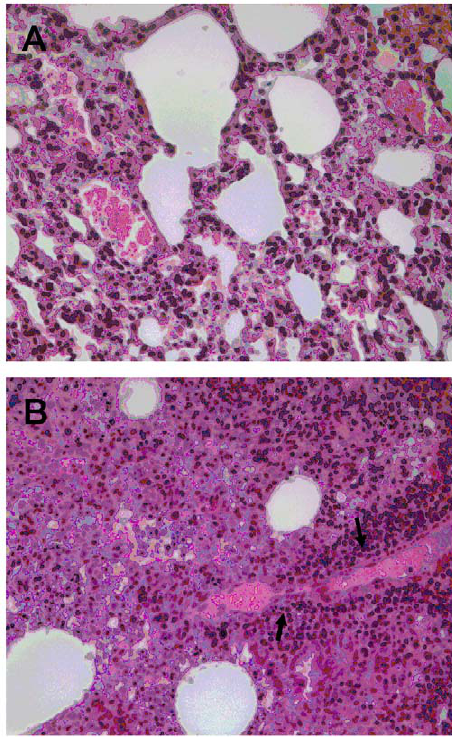
Figure 1. Histopathology of lung lesions in BALB/c mice. Pulmonary parenchyma from mice with reactivated infection, sacrificed 3 days after the end of dexamethasone treatment, showing interstitial inflammatory cell infiltrates comprising predominantly mononuclear leukocytes (A). Pulmonary parenchyma from mice at the time of primary infection (B) showing abundant inflammatory infiltrates and focal vasculitis (arrows). Hematoxylin and eosin stain, original magnifications 6 200.